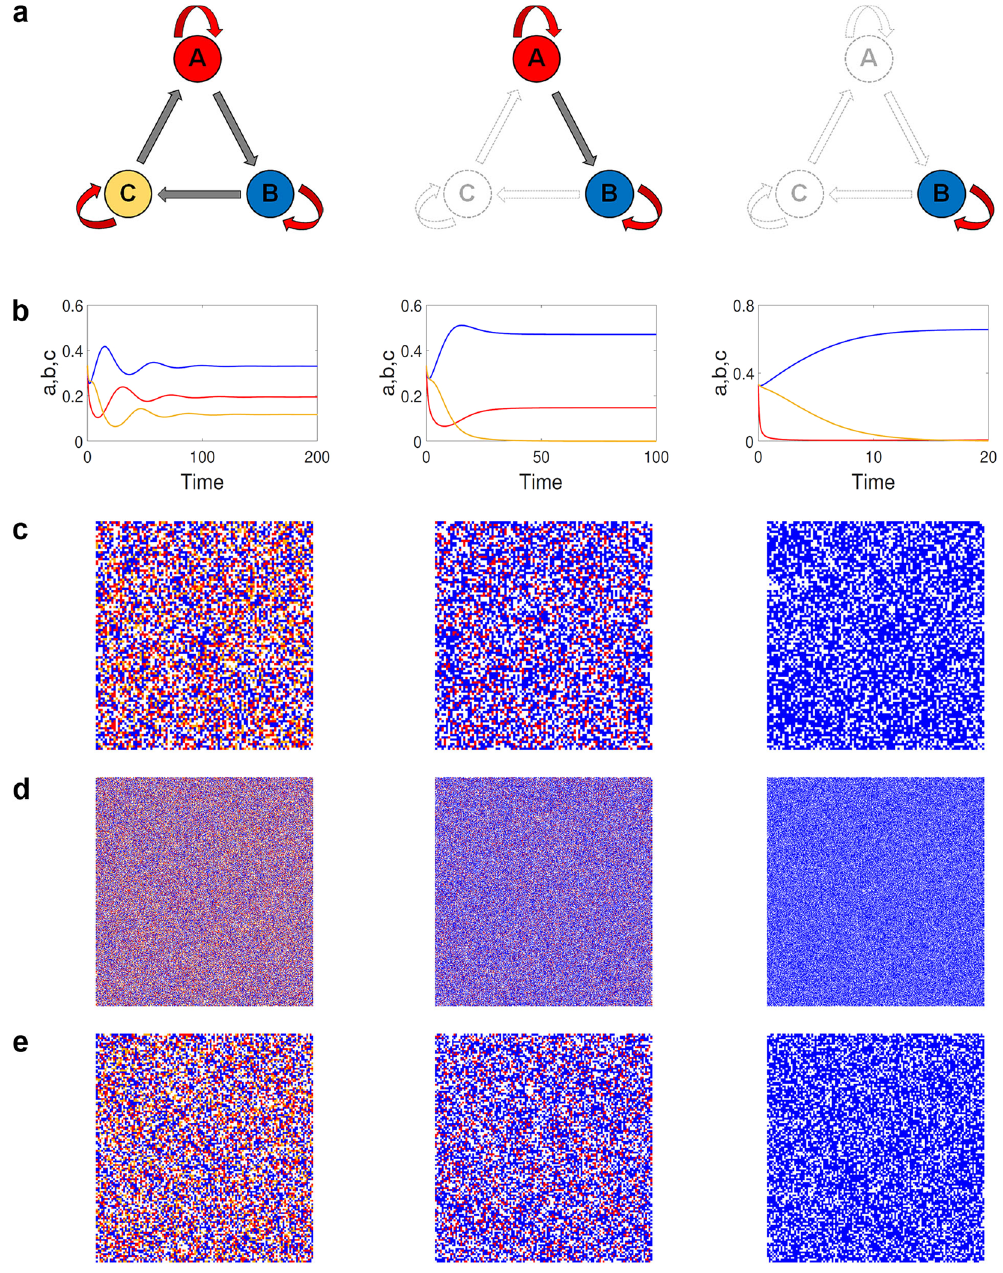
Figure 2. All possible coexistence states in RPS game. Red, blue and yellow colors indicate different species and blank denotes empty sites. ( a ) Three different types of surviving species. The left column corresponds to p a = 2.5, where ( b ) shows the density evolution from the ODE model, ( c ) and ( d ) present typical snapshots obtained from Monte Carlo simulations of lattice size N = 100 × 100 and 500 × 500, respectively, and ( e ) is a snapshot obtained from the PDE model. The middle and right columns are for p a = 5.2 and p a = 100, respectively. Other parameters are p b = 1.0 and p c =